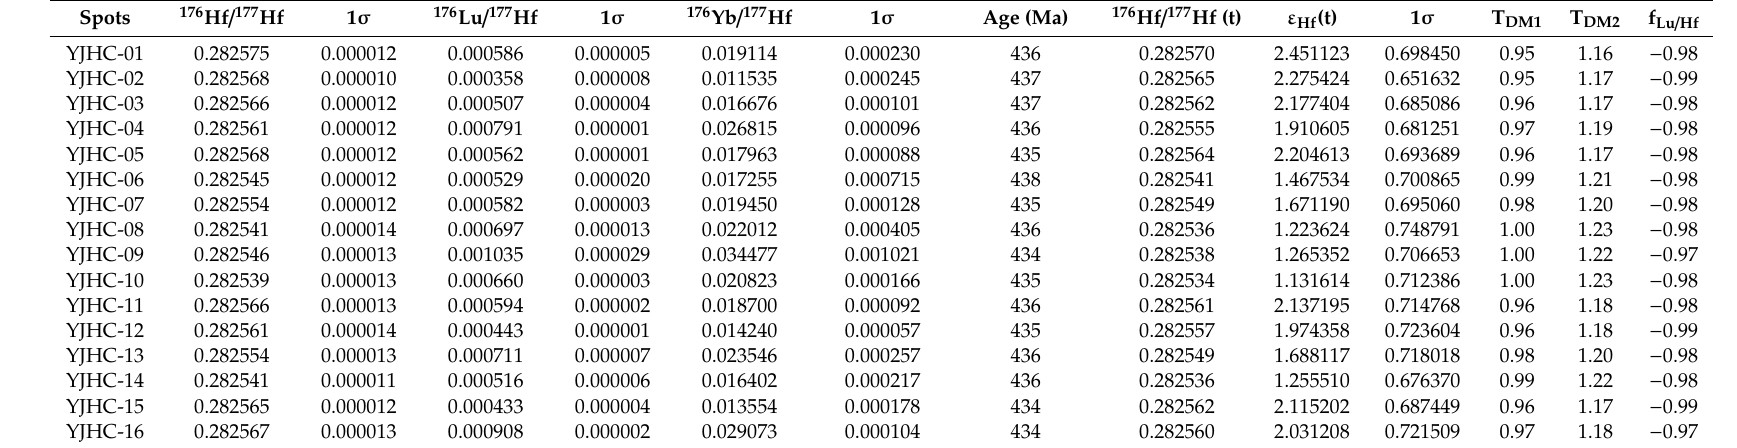
Table 3. LA–MC–ICP–MS zircon Lu–Hf isotope data for the zircons from Yuejingshan